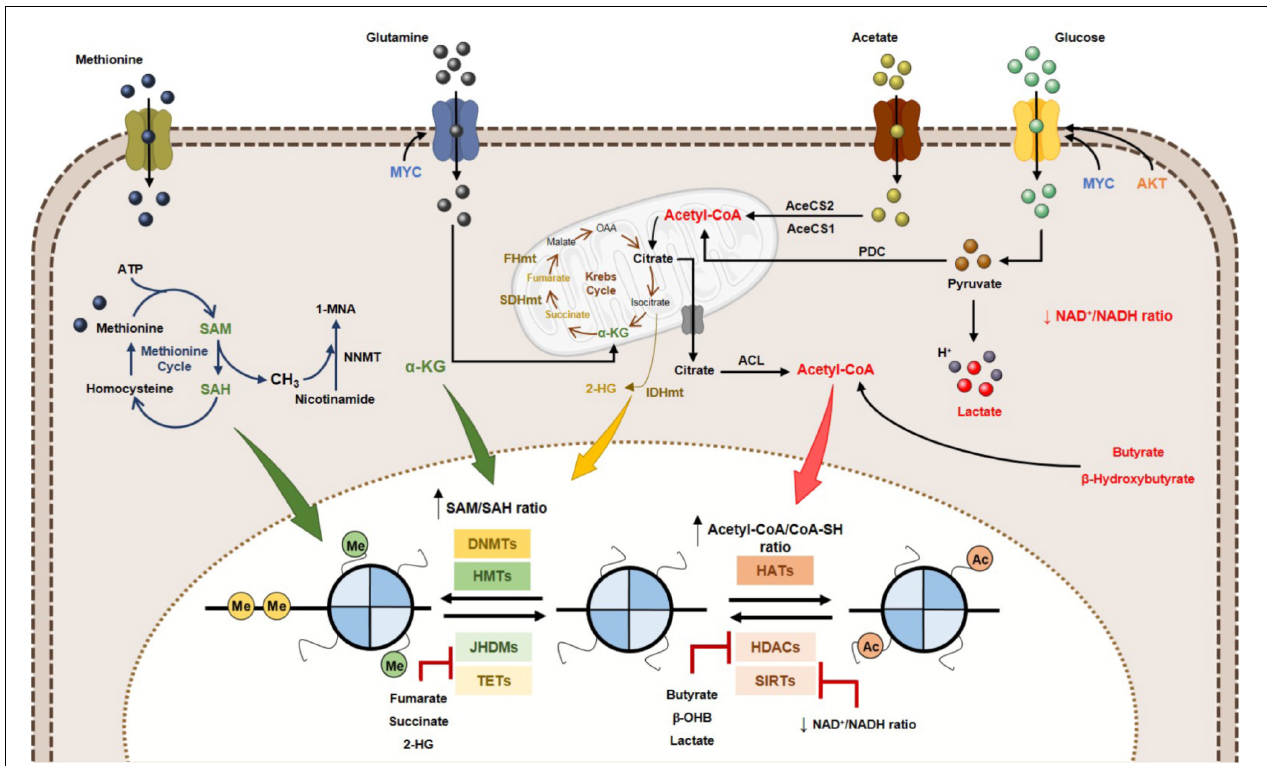
FIGURE 4 | Effect of metabolites on DNA and histone code in human cancer. Tumor metabolome modulates several epigenetic mechanisms, thus contributing to gene expression deregulation. Signaling pathways involving myc and HIF-1 α transcription factors upregulate the glucose and glutamine metabolism, which contribute to increased acetyl-CoA and α -KG production. High acetyl-CoA: CoA-SH ratio favoring HATs activity and consequently increased acetylation profile of tumor cells. Lactate, butyrate and β -hydroxybutyrate have been described as endogenous HDAC inhibitors. NAD + : NADH ratio is involved in Sirtuins’ activity regulation. SAM, synthetized from the essential amino acid methionine, is the substrate for HMTs and DNMTs. Other metabolites, such as fumarate, succinate and 2-HG has been identified as KDMs and TETs inhibitors, due to a structurally similarity to α -KG metabolite, a co-substrate to these enzymes. 2-HG, 2-hydroxyglutarate; AceCS1, acyl-CoA synthetase short-chain family member 1; AceCS2, acyl-CoA synthetase shirt-chain family member 2; ACL, ATP-citrate lyase; DNMTs, DNA methyltransferases; FHmut, fumarate hydratase mutant; HATs, histone acetyltransferases; HDACs, histone deacetylases; HMTs, histone methyltransferases; IDHmut, isocitrate dehydrogenase mutant; JHDMs, Jumonji-C domain-containing histone demethylases; PDC, pyruvate dehydrogenase complex; SAH, S -adenosylhomocysteine; SAM, S -adenosylmethionine, SDHmut; SIRTs, sirtuin’s; TETs, ten-eleven translocation family; α -KG,